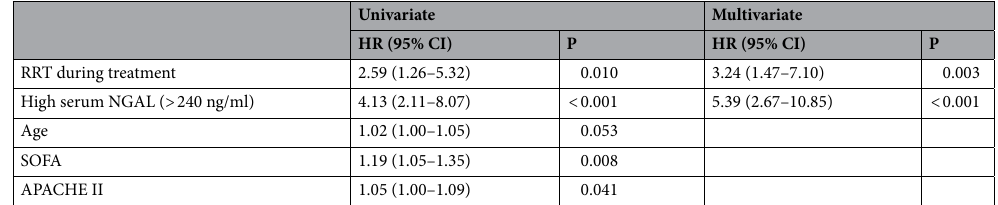
Table 2. Cox proportional hazards regression analysis on serum NGAL for ICU mortality. HR hazard ratio, CI confidence interval, RRT renal replacement therapy, NGAL neutrophil gelatinase-associated lipocalin, SOFA sequential organ failure assessment, APACHE II Acute Physiology and Chronic Health Evaluation